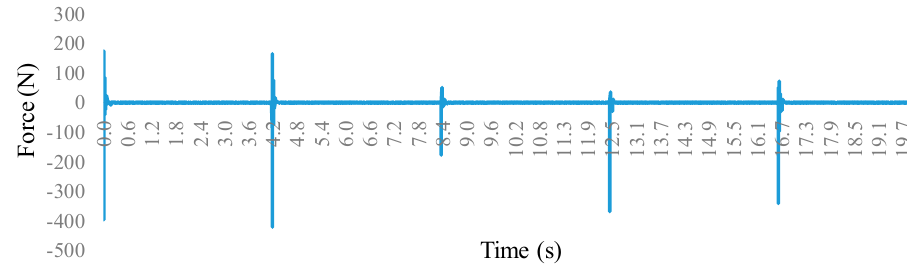
Figure 7. The time-history curve of force.